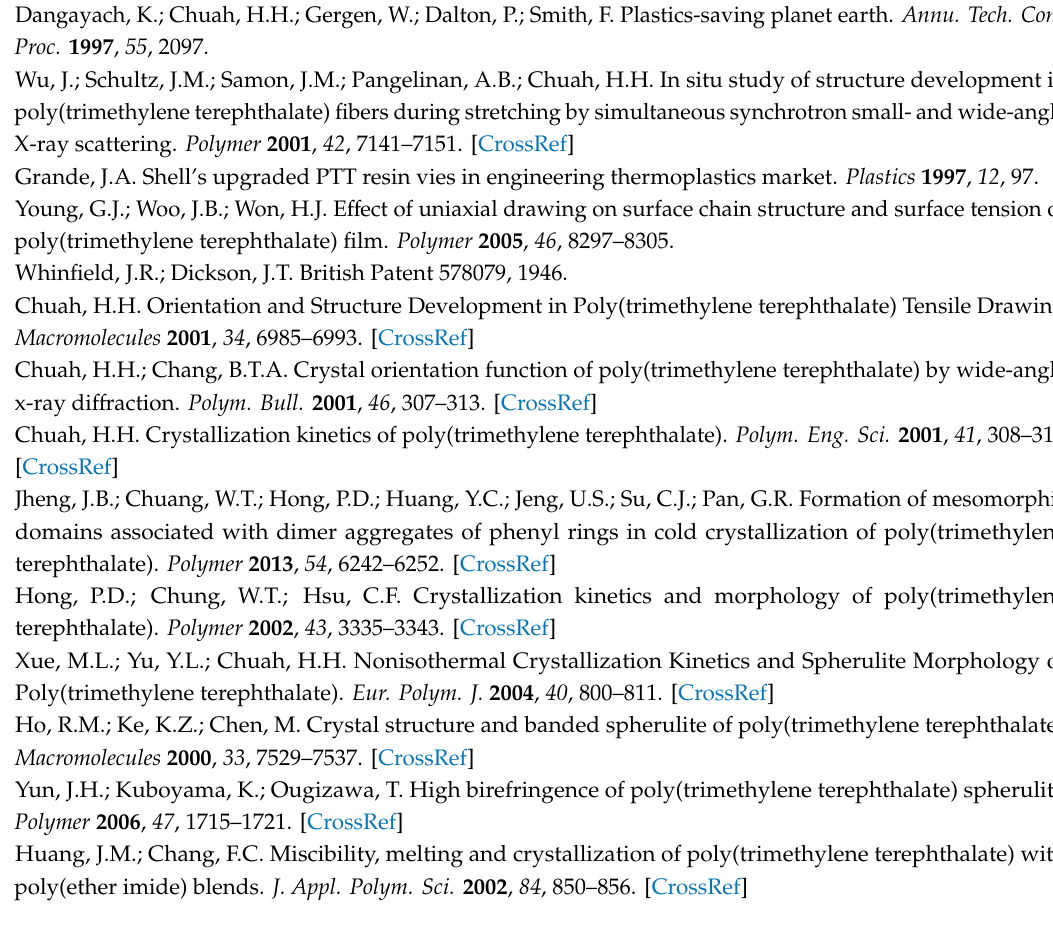
Figure S1: Scheme showing the di ff erences between the surface treatment agents and surface properties of Closite 30B and Closite